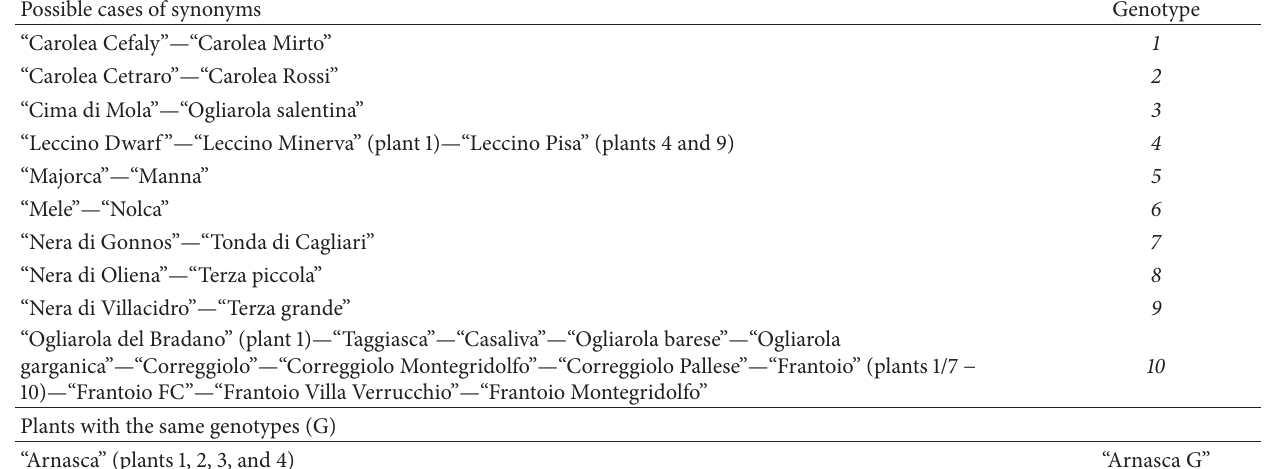
Table 2: Potential cases of mislabelling, redundancies, homonymy, and synonymy identified by microsatellite fingerprinting on 489 Italian olive